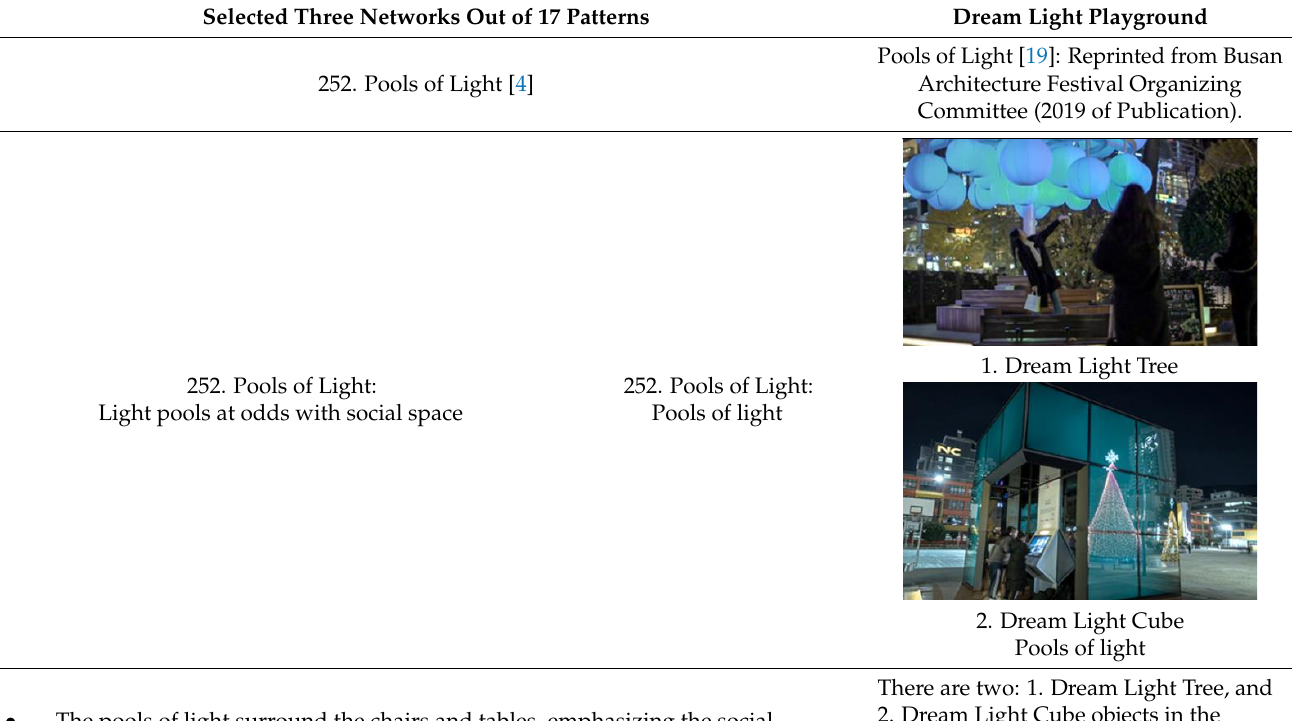
The pools of light surround the chairs and tables, emphasizing the social character of the space they form. There cannot be pools of light without the darker places in between them.